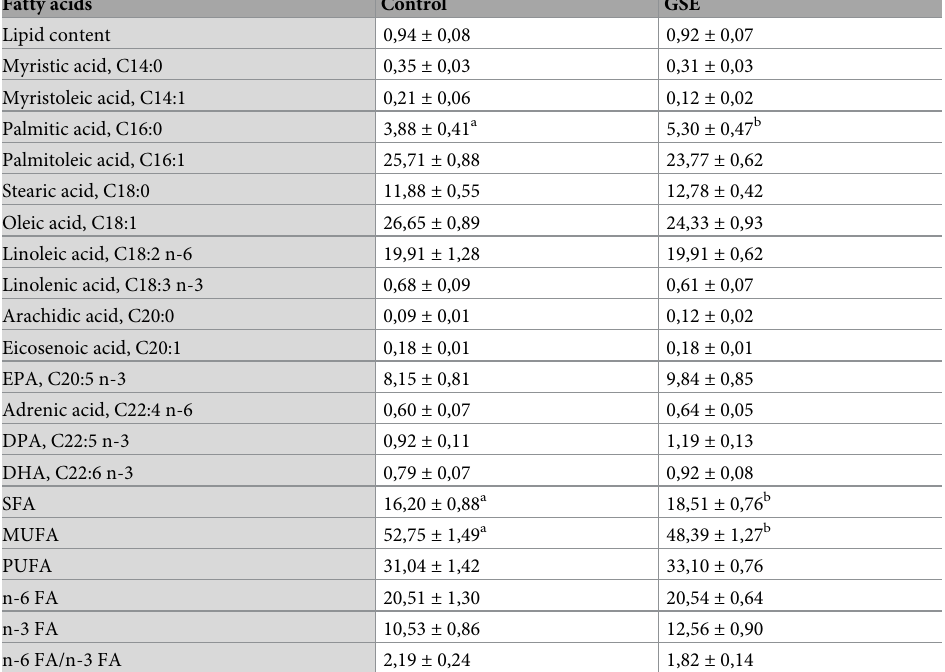
Table 1. Fatty acid composition of pectoralis